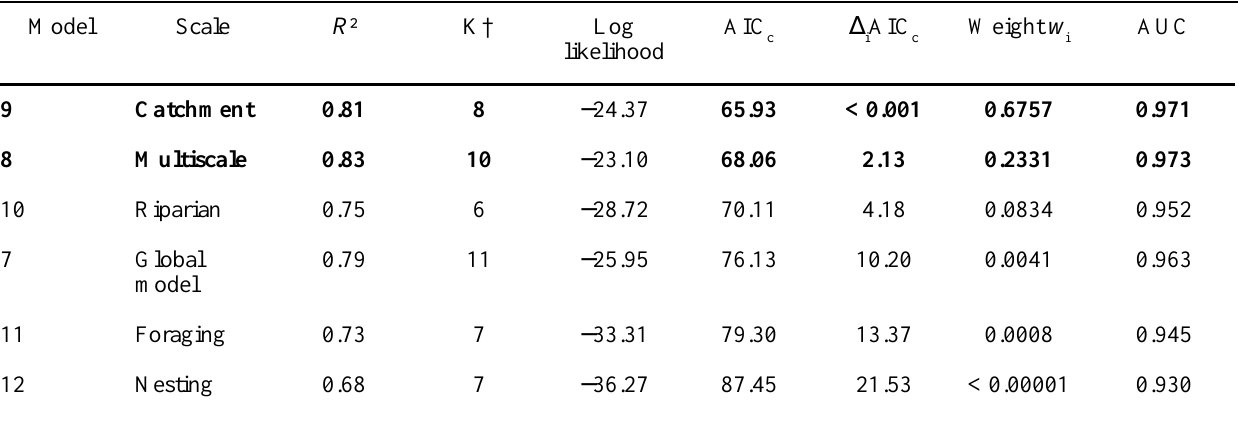
Table 6. Summary of results for ecoregion 2 (New Hampshire-Vermont Upland) habitat models with their associated Akaike weights. N = 130 lakes. Models with empirical support, i.e., D iAIC in